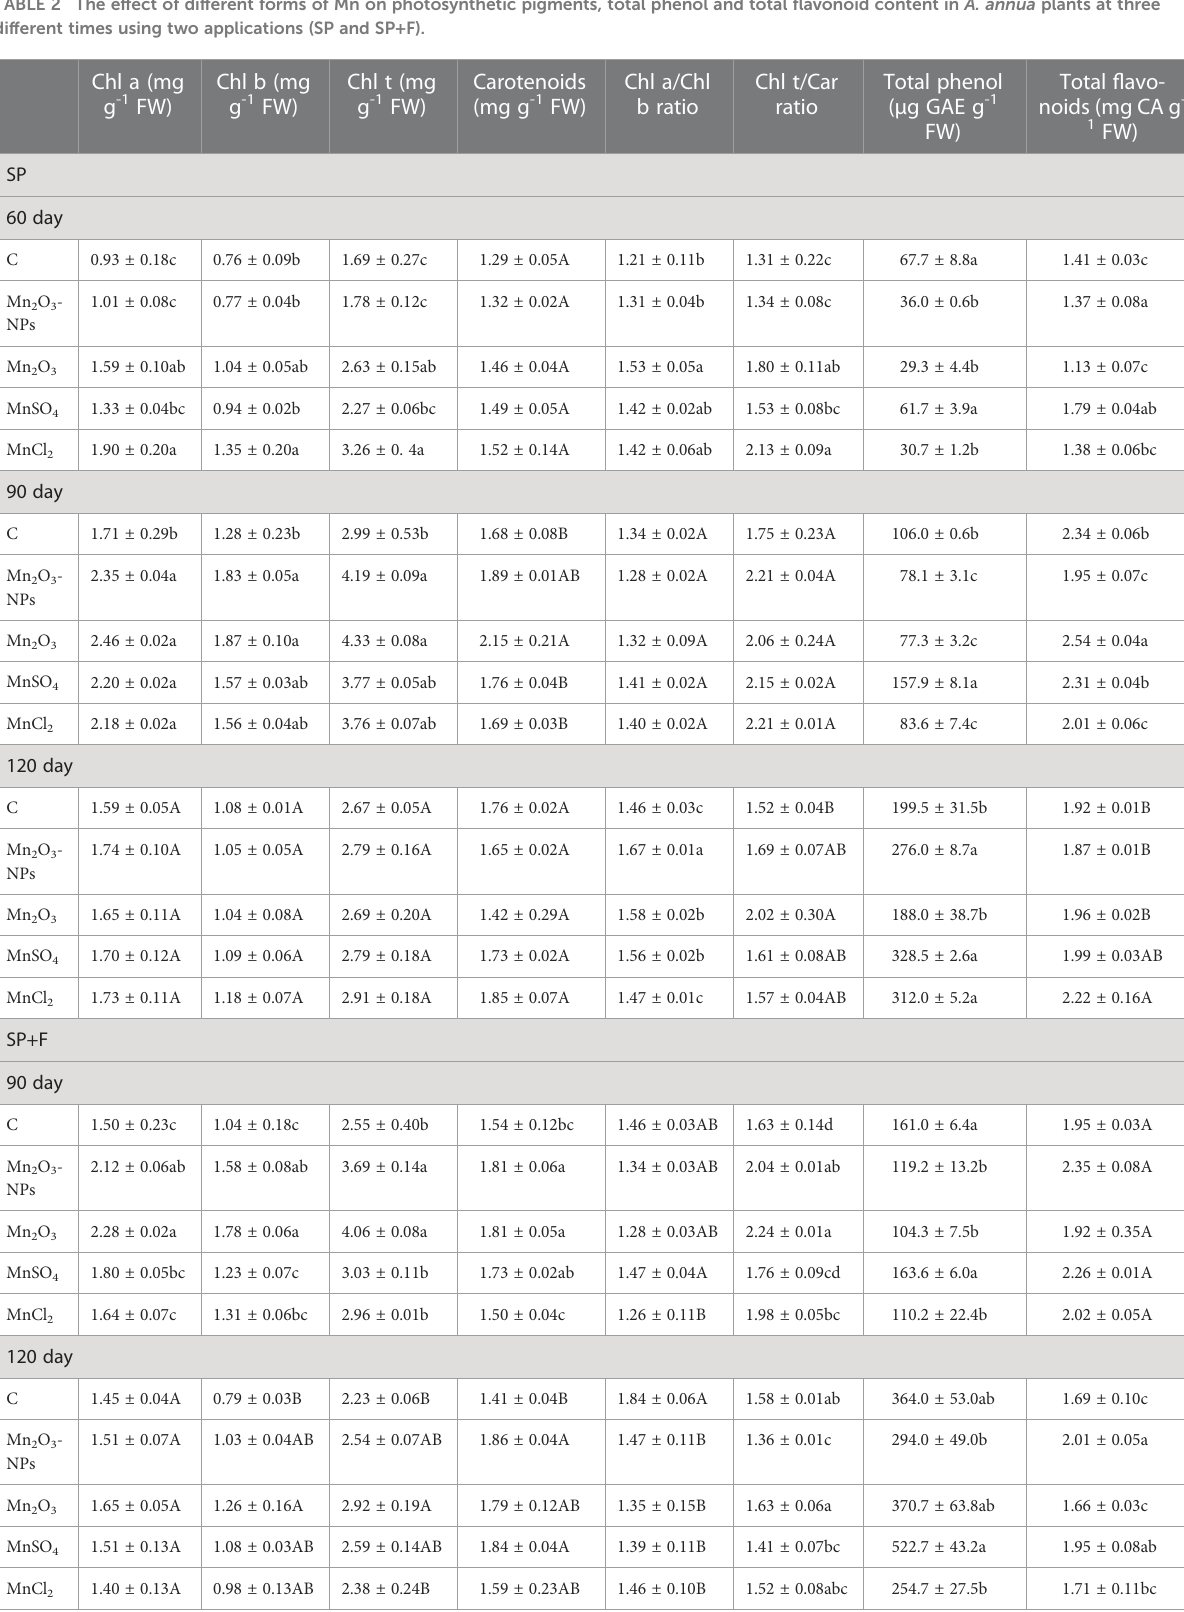
TABLE 2 The effect of different forms of Mn on photosynthetic pigments, total phenol and total fl avonoid content in A. annua plants at three different times using two applications (SP and SP+F).